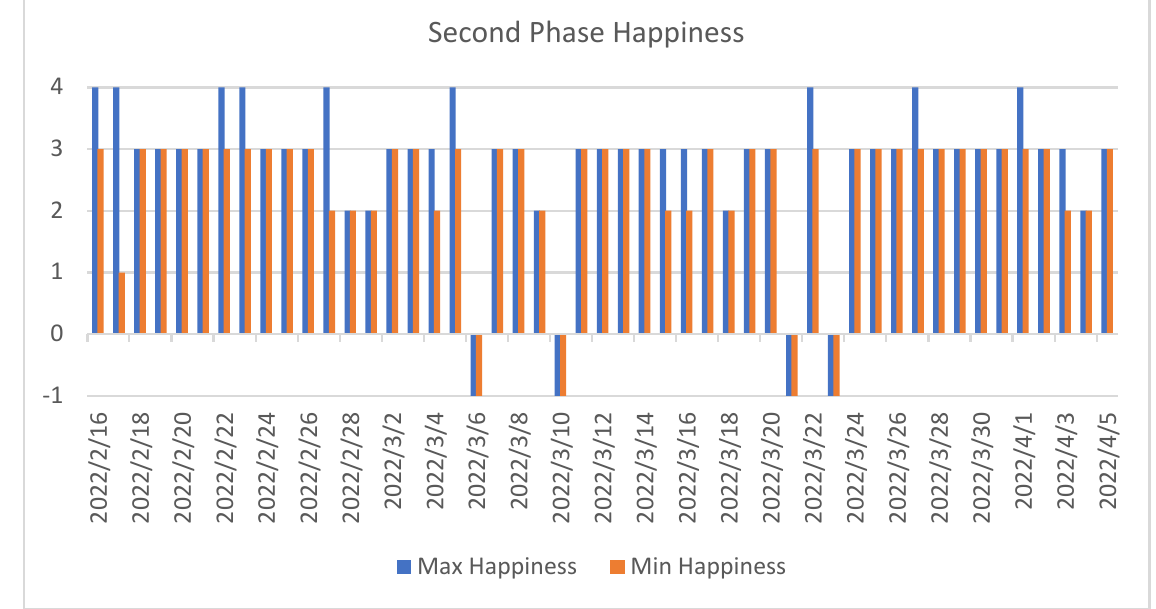
Figure 16. Second phase of the experiment. This figure shows the maximum and minimum happiness values recorded each day for the second subject.